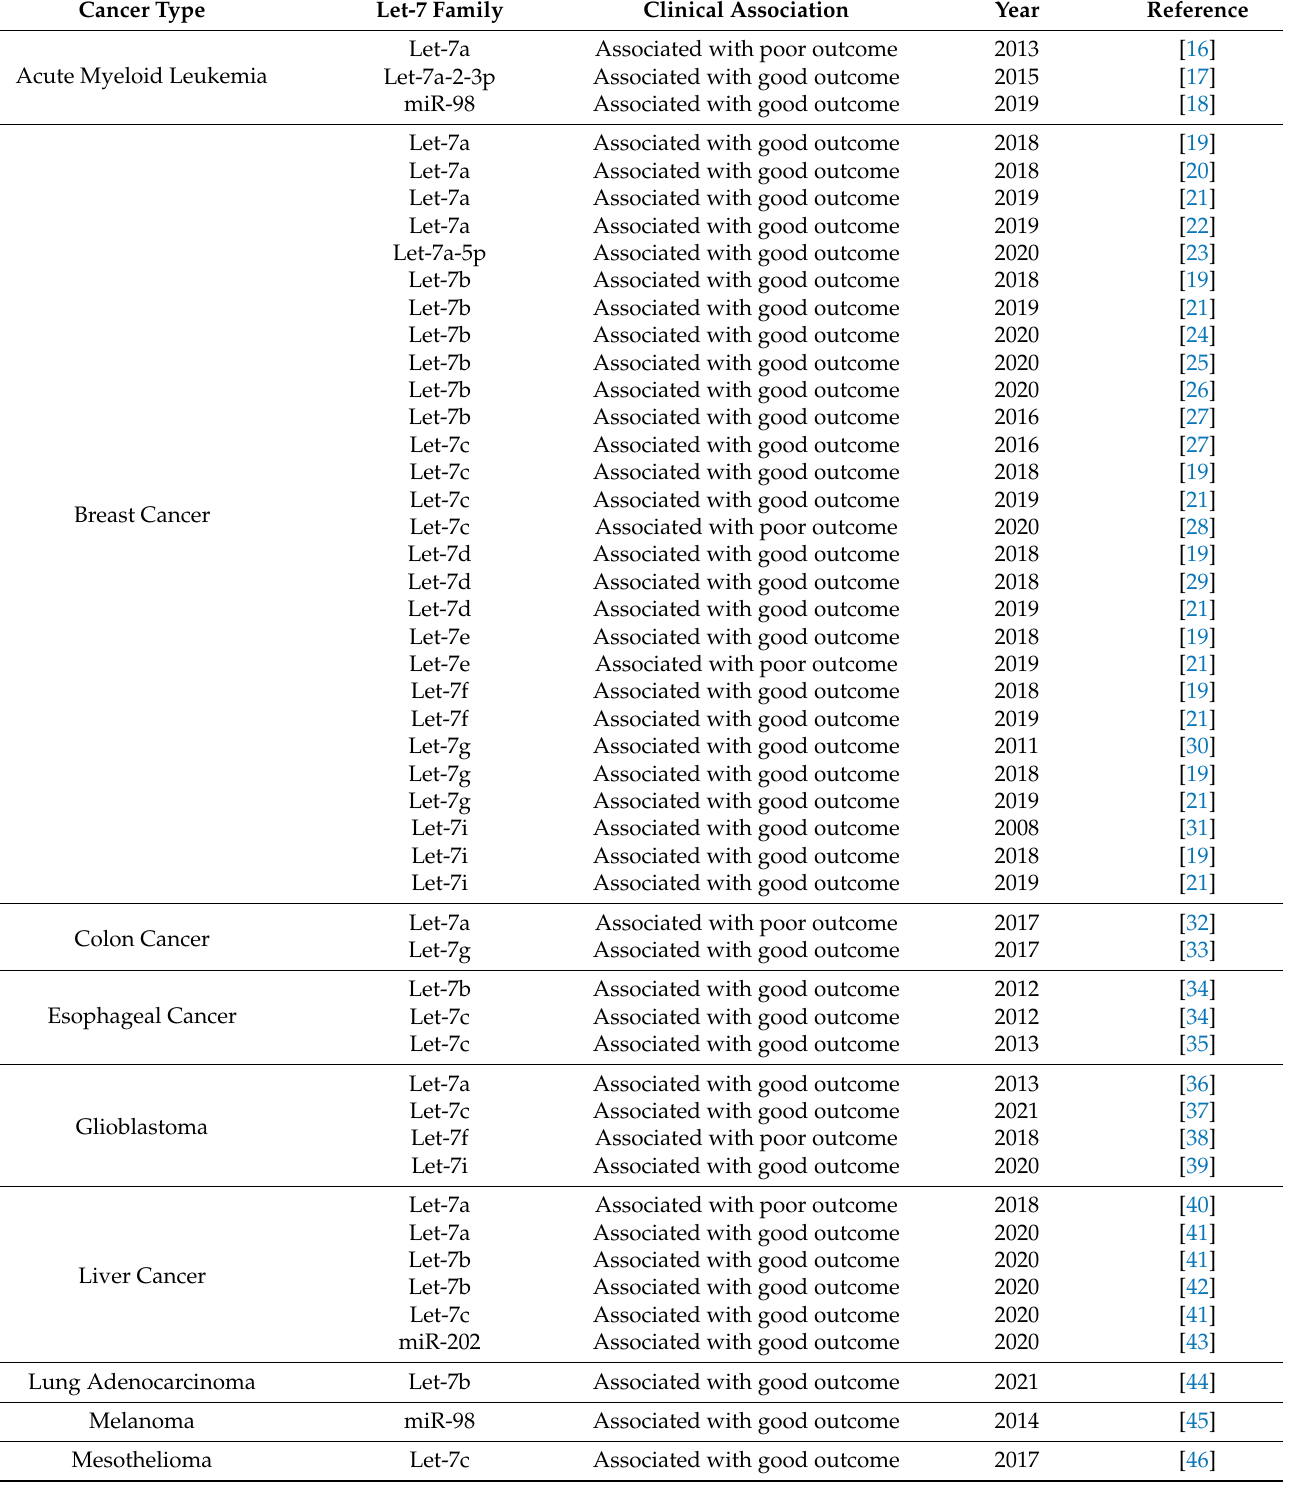
Table 2. Let-7 family in pan-cancer on the basis of literature review to coordinate the related survival correlation between patients with cancer and the Let-7